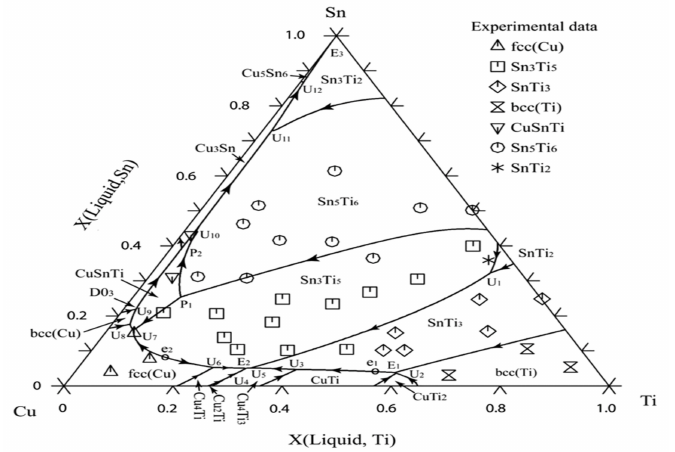
Figure 29. Liquidus projection of Cu-Sn-Ti ternary system superimposed with experimental data of primary solidification [69].